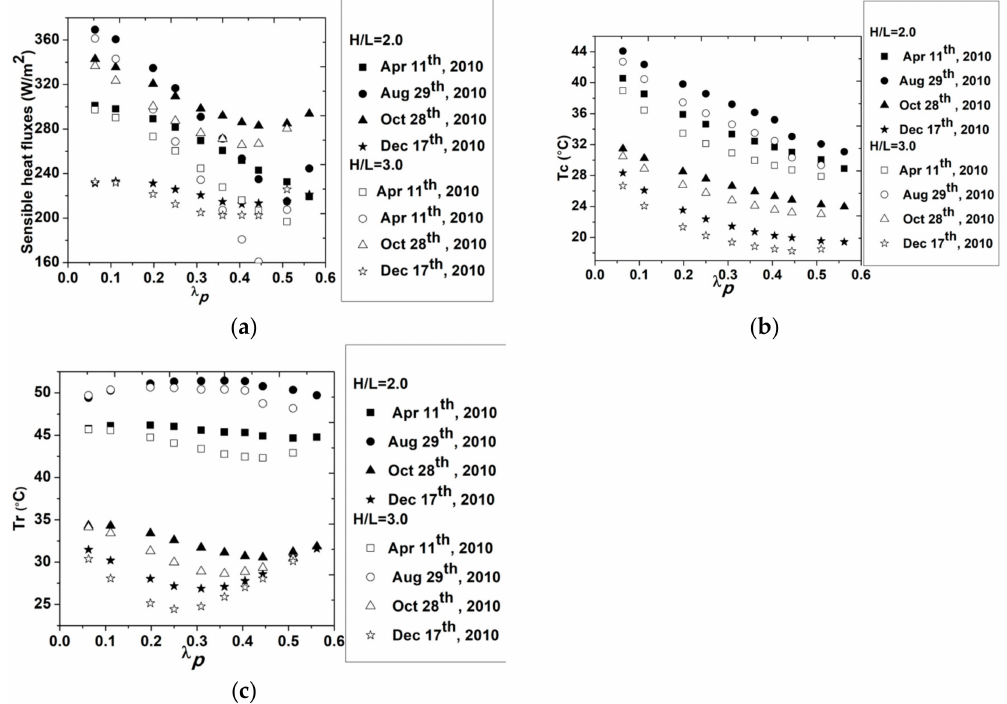
Figure A2. Changes in sensible heat flux ( a ) T c ( b ) and T r ( c ) with λ p